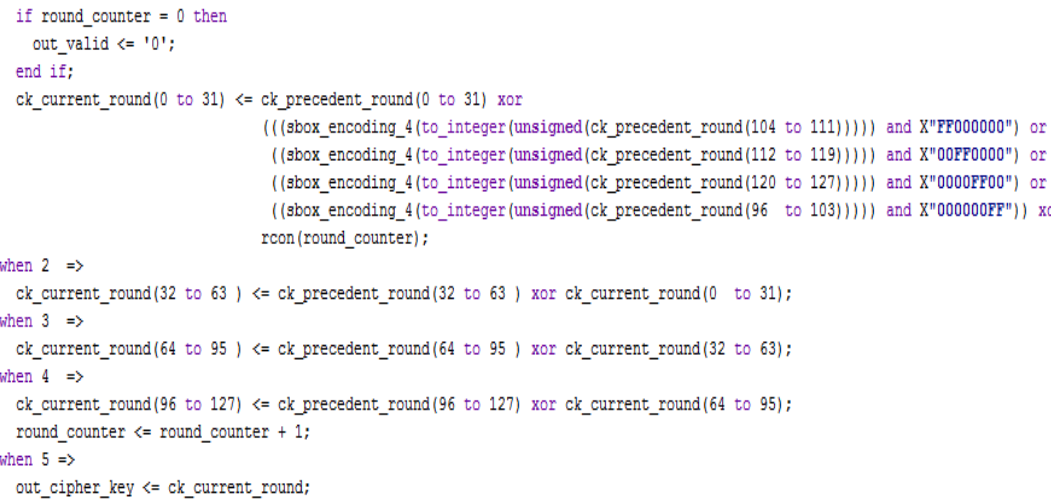
Figure 9. Source files used to implement the code performing the encryption process.